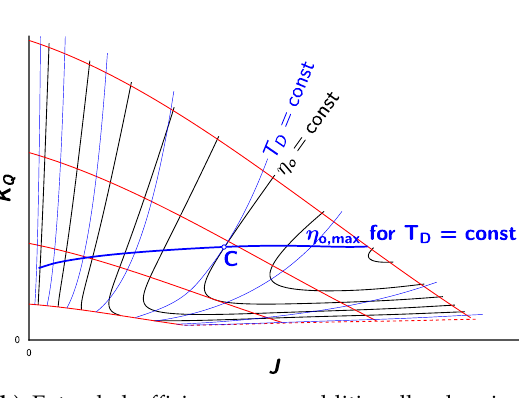
( a ) Basic efficiency map showing K Q (thin red lines), ( b ) Extended efficiency map additionally showing K T = const (dotted red lines), η o = const (thin black T D = const (thin blue lines) and the construction of lines), and the construction of “ η o , max for J = const” “ η o , max for T D = const” (point C, bold blue line). (dotted black line and point A, bold black line) and “ η o , max for P / D = const” (point B, bold red line). Figure 3. Composition of the K Q – J efficiency map. For its construction, see Appendix